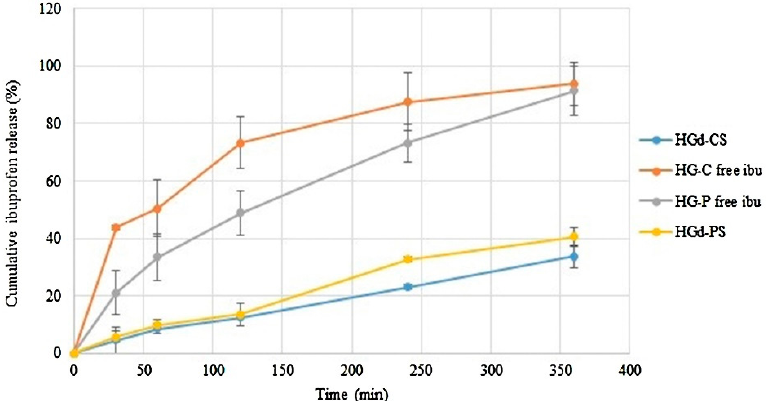
Figure 2. In vitro release profile of ibuprofen from hydrogels with Carbopol ® 980 (HGd-CS), hydrogels with polycarbophil (HGd-PS), Carbopol ® 980 gel with free ibuprofen (HG-C free ibu) and polycarbophil gel with free ibuprofen (HG-P free ibu). Reprinted with permission from [29]. Copyright© 2017 Elsevier.